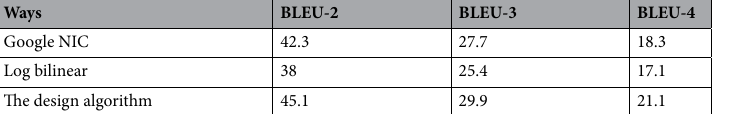
Table 6. The results of the experiments on the database Flickr30K. Methods are divided into Google NIC, Log Bilinear and The design algorithm.